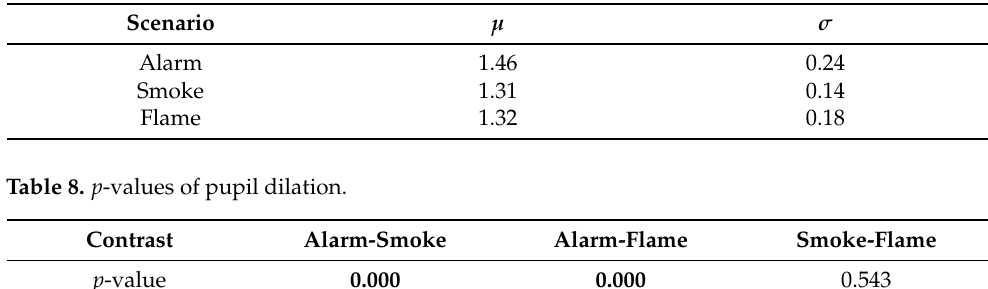
Table 7. Mean values and standard deviations of pupil dilation.